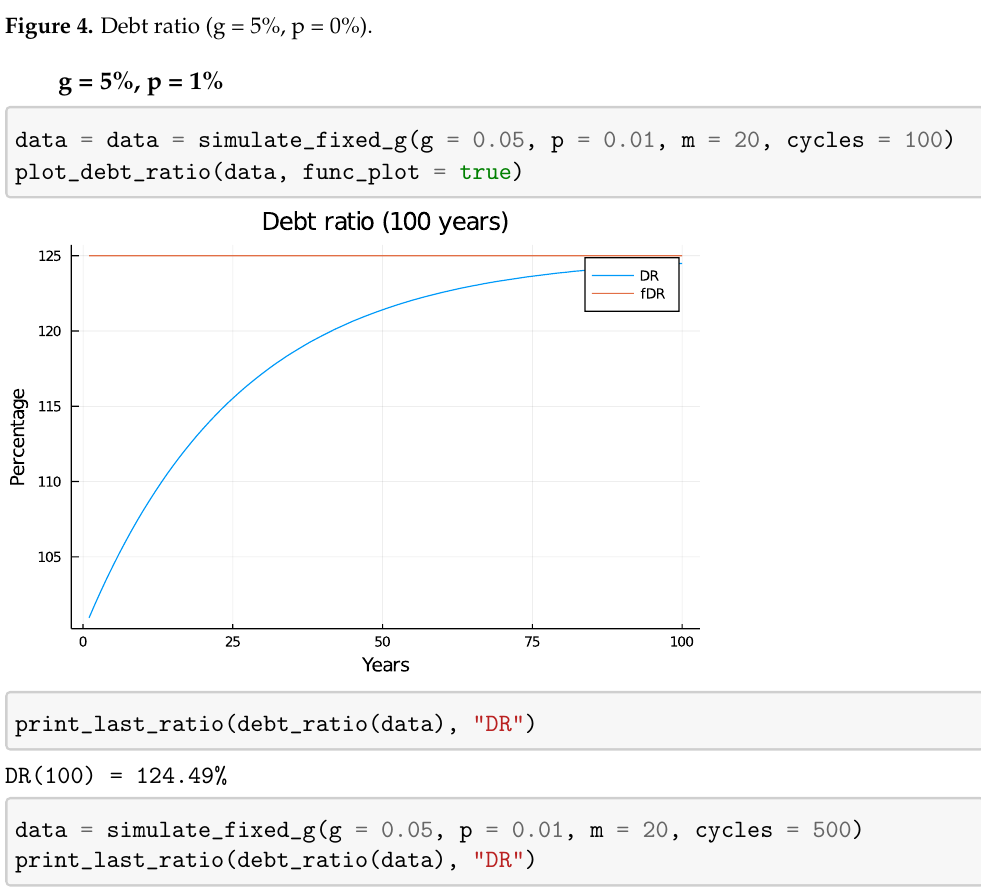
Figure 5. Debt ratio (g = 5%, p =